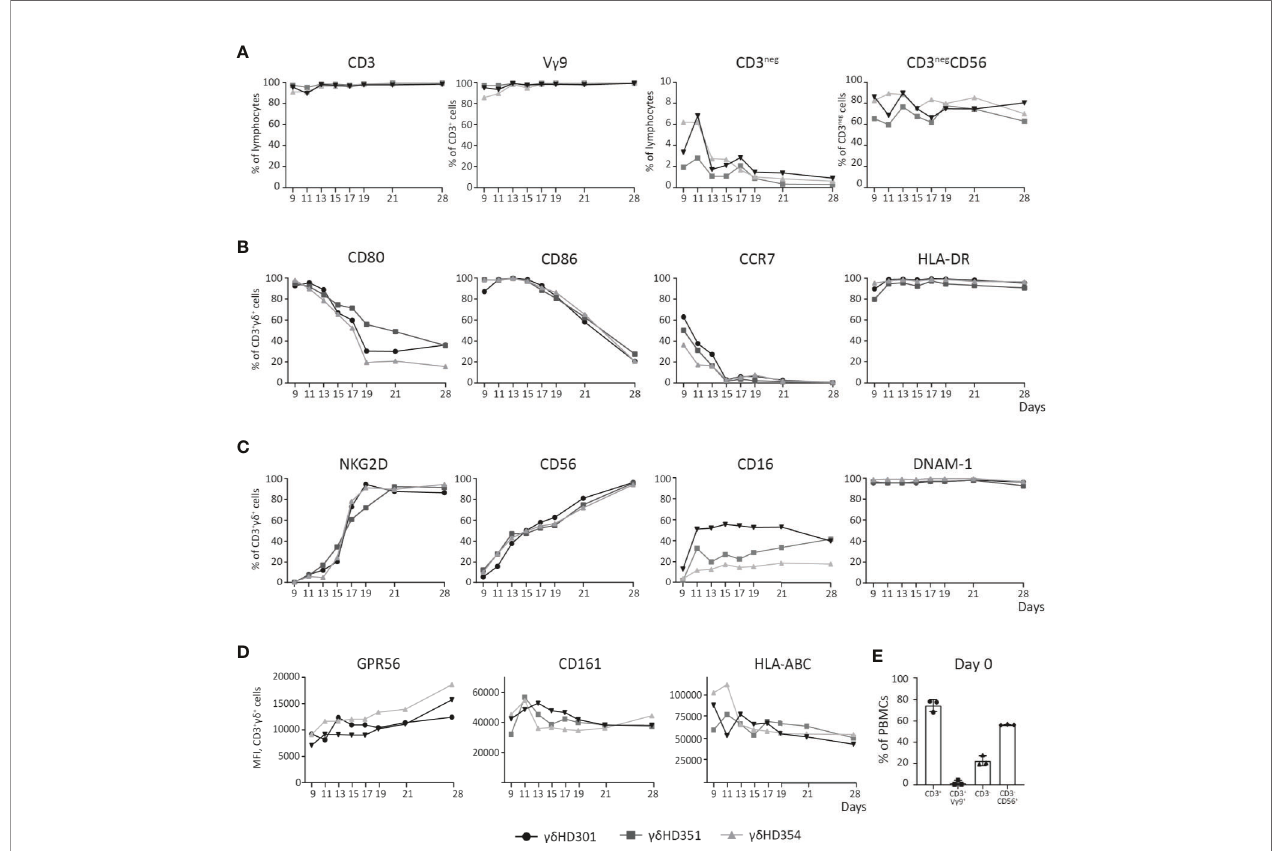
FIGURE 2 | Phenotype analysis of V g 9V d 2 T cell cultures over time. V g 9V d 2 T cells cultures were expanded from three different healthy donors (HD), and analyzed by fl ow cytometry during culturing time in vitro up to 28 days. (A) Purity of the V g 9V d 2 T cell cultures is shown, by looking at both CD3 pos and V g 9V d 2 (V g 9) T cells, but also CD3 neg and NK (CD3 neg CD56) cells. (B) V g 9V d 2 T cell percentage expression of CD80, CD86, CCR7 and HLA-DR is shown. (C) V g 9V d 2 T cell percentage expression of NKG2D, CD56, CD16, and DNAM-1 is shown. (D) Finally, V g 9V d 2 T cells expression of GPR56, CD161 and HLA-ABC is shown by MFI values. (E) Purity analysis on day 0 of the PBMCs used for expansion to V g 9V d 2 T cells cultures. Complete gating strategies can be found in Supplementary Figure 1 .